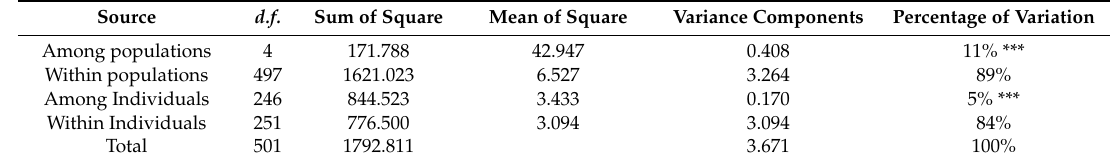
Table 3. Analysis of molecular variance (AMOVA) for Dalbergia odorifera populations. Source d.f. Variance Components Among populations